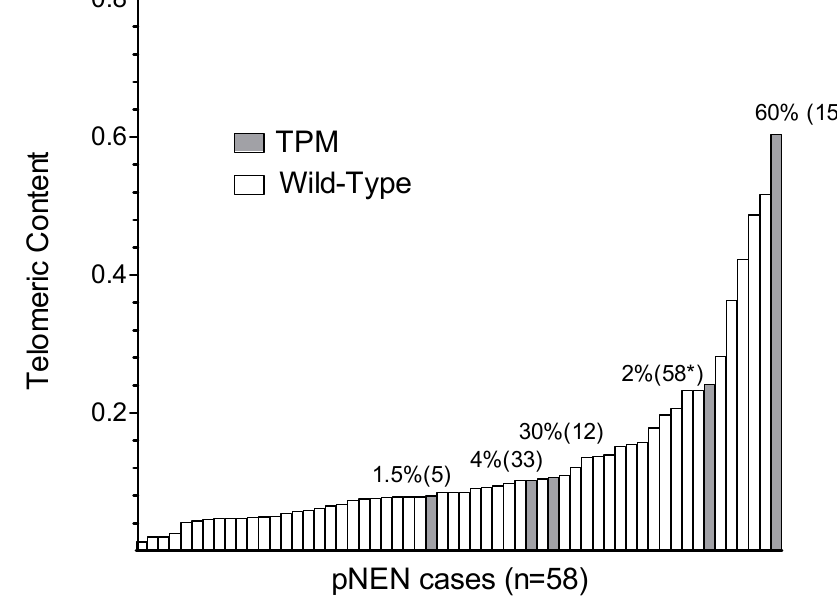
Figure 3. Telomere length and TPM status. Telomeric content was determined as T / S ratio by qPCR relative to control cell line U2OS with long telomeres defined as 1. Relative telomere lengths of pNEN cases are shown as waterfall blot. TPM cases are marked by filled bars and shown with T allele frequencies and case numbers in